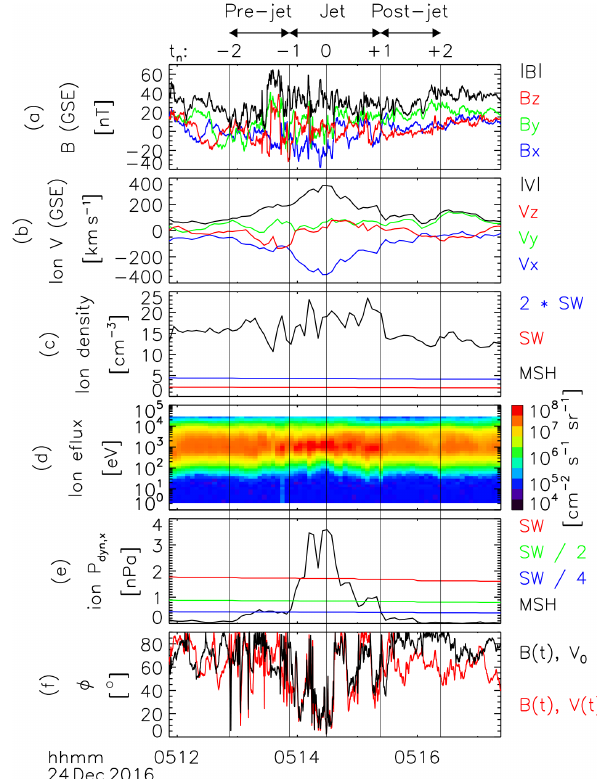
Figure 2. Jet example: MMS 1 magnetosheath and OMNI solar- wind data of 24 December 2016. From top to bottom: (a) magnetic- field B in GSE; (b) ion velocity V in GSE; (c) ion density in the magnetosheath in black and (twice) the ion density in the solar wind in red (blue); (d) magnetosheath ion energy flux density; (e) P dyn ,x in the magnetosheath in black and in the solar wind in red (half and one quarter thereof in green and blue); and (f) angles φ B , V in black and φ B , V in red based on magnetosheath observations. Vertical lines show normalized times t n = − 2 to